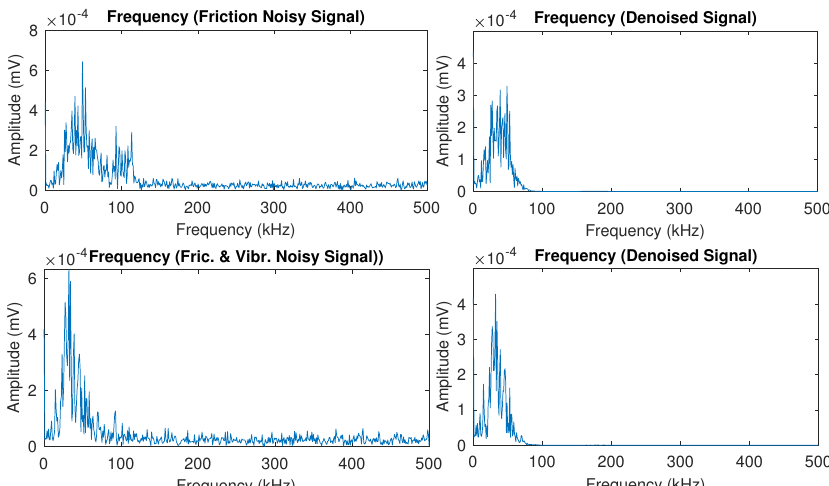
Figure 7. Comparison between the frequency components of the Original noisy AE signals and ND-SWT-based denoised signals.